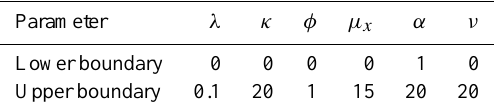
Table 1. Pre-defined boundaries for the parameters of the MBL model during calibration, applicable to all